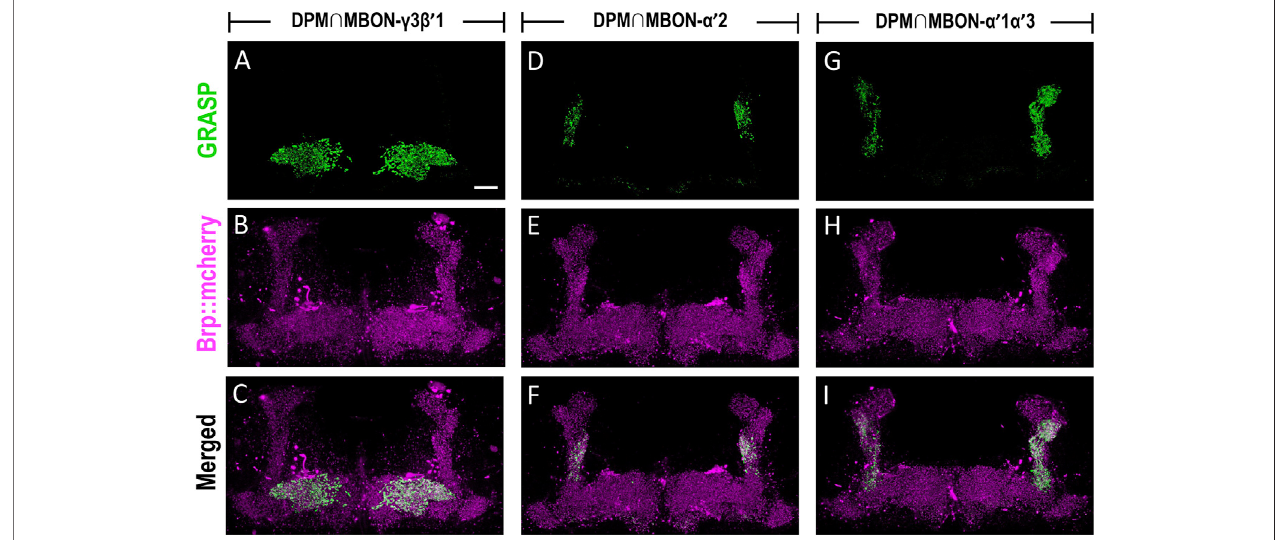
FIGURE6| MBON- γ 3 β ′ 1,MBON- α ′ 2,andMBON- α ′ 1 α ′ 3aredownstreamcircuitsofDPMneurons.TheconnectivityofMBON- γ 3 β ′ 1,MBON- α ′ 2,MBON- α ′ 1 α ′ 3, and DPM were visualized using GRASP. (A – C) GRASP signals (green) were observed in β ′ 1 and γ 3 subregions of MB horizontal lobes in fl ies carrying L0111-LexA/+; MB083C-GAL4/lexAop-spGFP 11 , UAS-spGFP 1-10 , lexAop-Brp::mCherry transgenes.The axons ofthe DPM neurons were labeled withBrp::mcherry(magenta). (D – F) GRASP signals (green) were observed in α ′ 2 regions in fl ies carrying L0111-LexA/+; MB091C-GAL4/lexAop-spGFP 11 , UAS-spGFP 1-10 , lexAop-Brp::mCherry transgenes.TheaxonsoftheDPMneuronswerelabeledwithBrp::mcherry(magenta). (G – I) GRASPsignals(green)wereobservedin α ′ 1, α ′ 3,and α ′ 2subregionsin fl ies